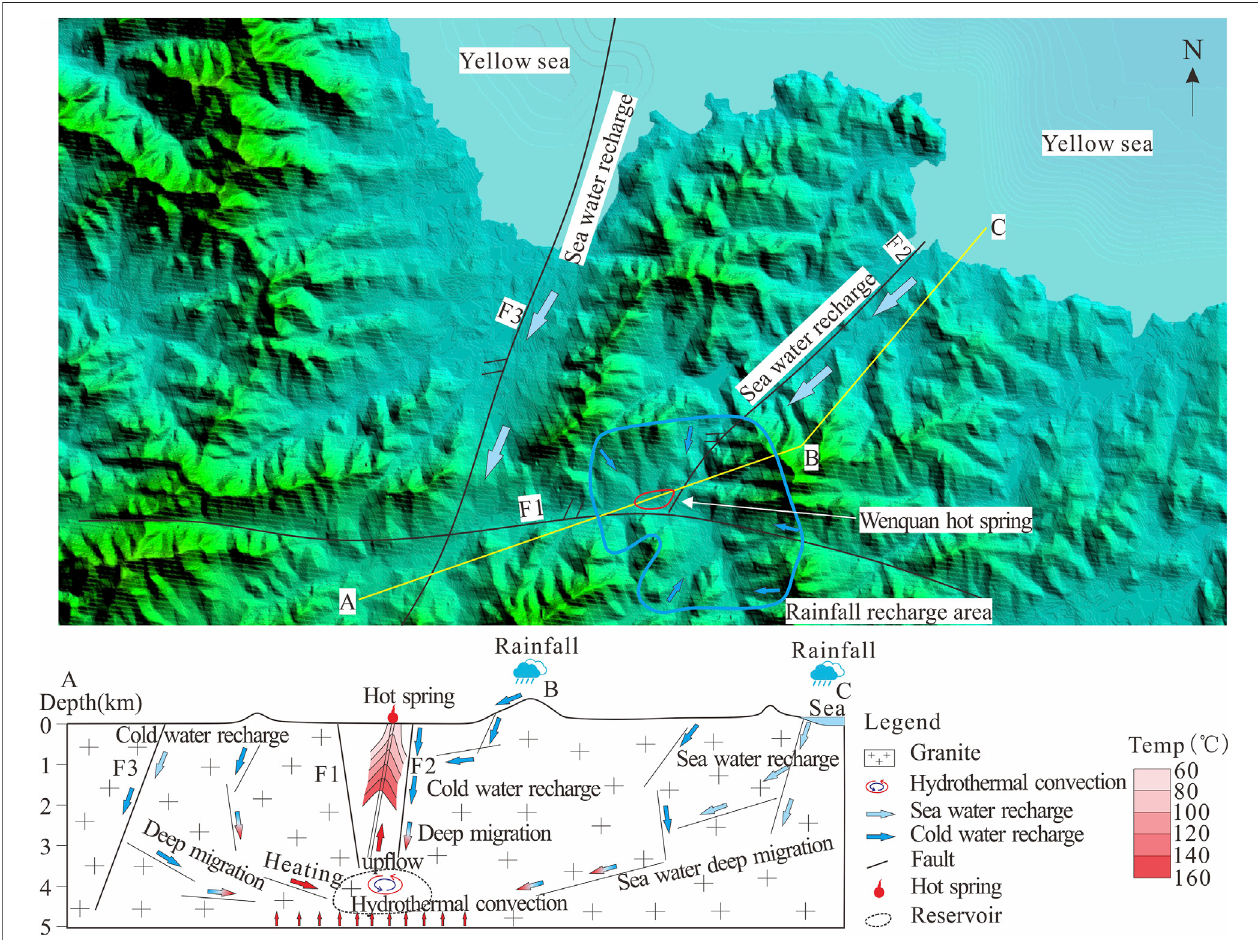
FIGURE 14 | Recharge, runoff, drainage, and heat sources of the Wenquan hot springs geothermal fi eld.